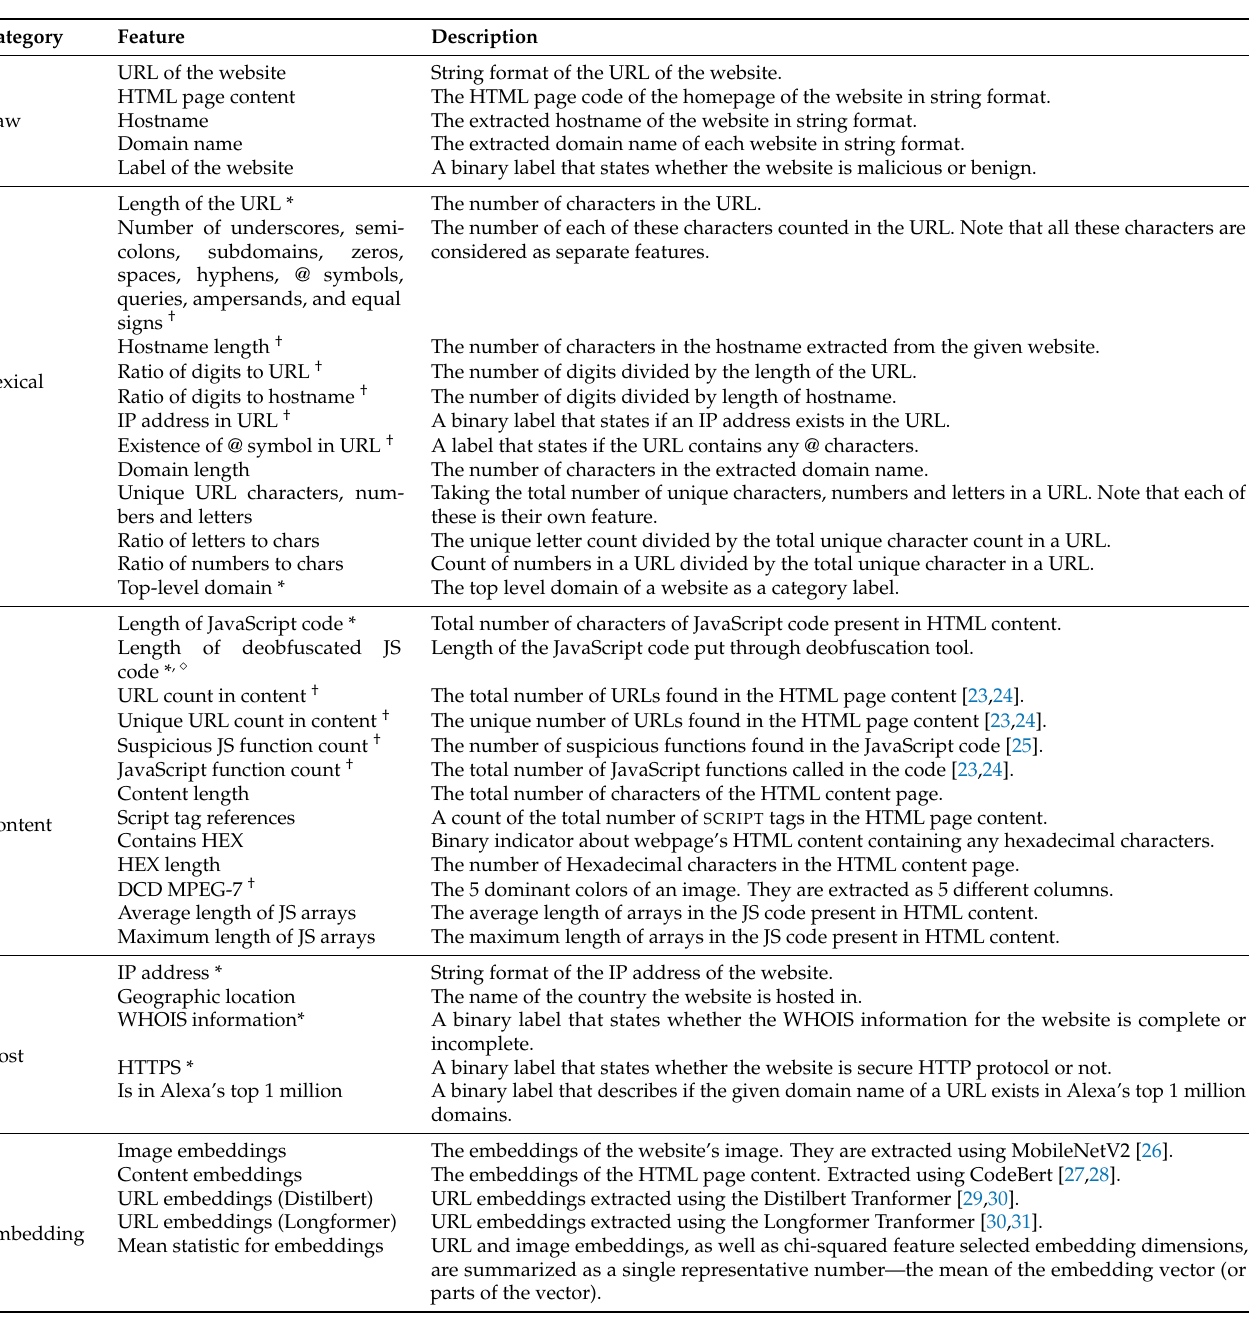
Table 1. List of features covered in this study. The labels indicate: * part of the A.K. Singh’s dataset, † part of the expanded dataset used in Section 3, (cid:5) not part of the our final dataset